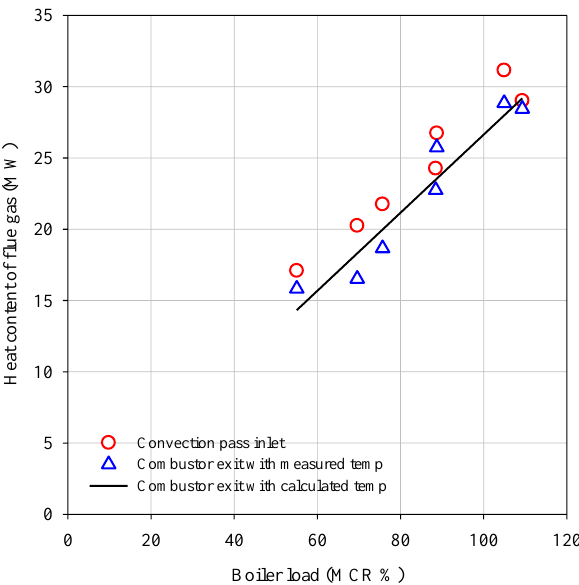
Figure 5. Flue gas heat content at the combustor exit and convection pass inlet based on both the measured and calculated temperatures.